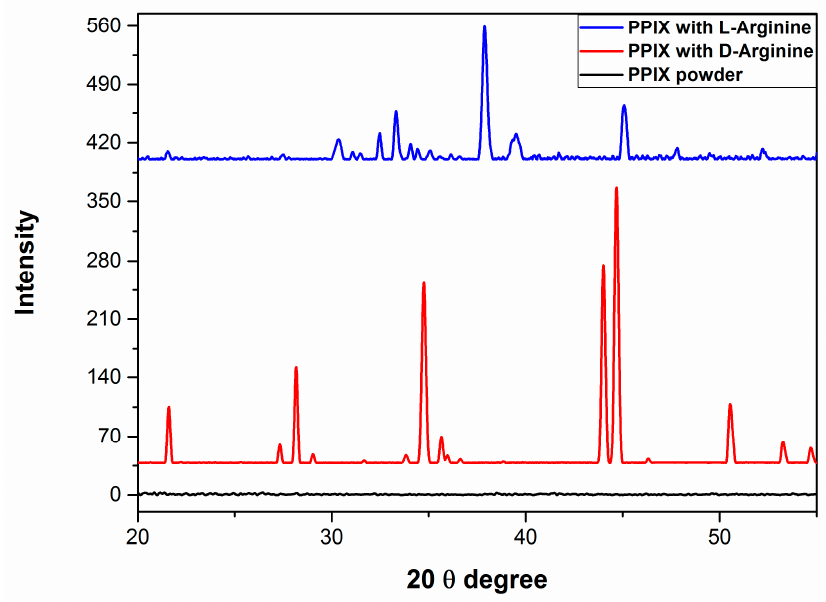
Figure 4. X-ray di ff raction patterns of PPIX, PPIX / d -arginine and PPIX / l -arginine at a 1:4 molar Figure 4. X-ray diffraction patterns of PPIX, PPIX/ D -arginine and PPIX/ L -arginine at a 1:4 molar ratio.